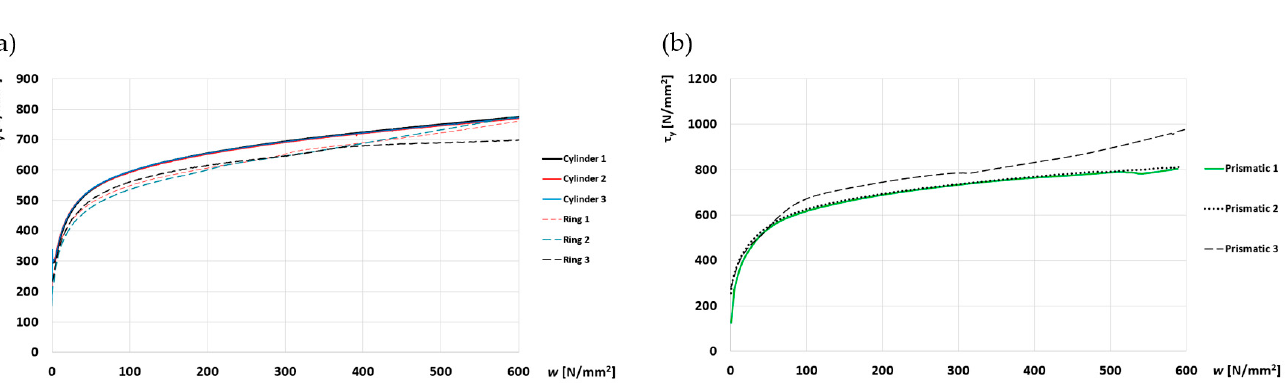
Figure 8. Variation of σ y and τ y with the plastic work for cylinder and ring ( a ), and prismatic specimens ( b ).